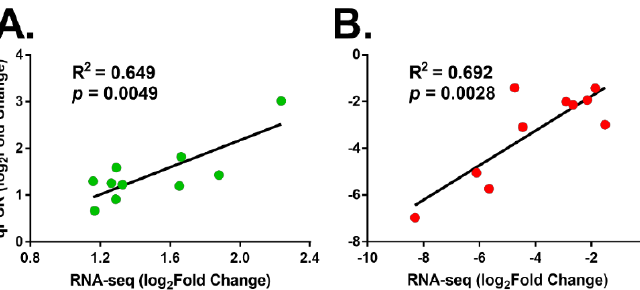
Figure 6. Validation of expression levels of DEGs involved in host metabolism and immunity using qPCR. ( A ) Expression levels of 10 upregulated DEGs in the parasitized FAW compared to those in unparasitized hosts using qPCR and RNA-seq data. ( B ) Expression levels of 10 downregulated DEGs in parasitized FAW compared to those in unparasitized hosts using qPCR and RNA-seq data. Log 2 Fold change(qPCR) values were plotted against the log 2 Fold change (FPKM) values in gene expression after wasp parasitization detected by RNA sequencing. The reference line indicates a linear relationship between the two techniques, and R denotes the Pearson correlation